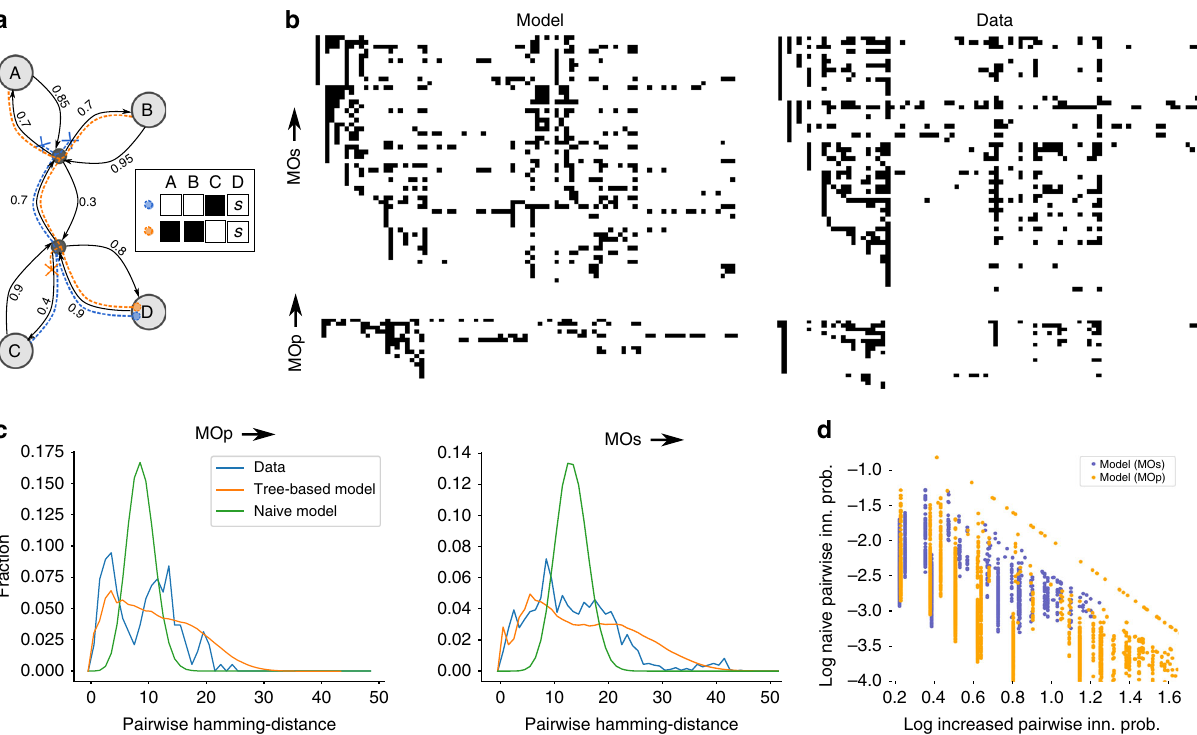
Fig. 6 A model to generate p-types. a Toy example of a p-type generating model with four regions (A – D). The regions are associated with the leaves of a directed tree (black), edges of the tree are associated with a probability to cross it. Two exemplary axons (orange, blue) spread from region D either crossing an edge (dashed lines) or not (dashed X-marks). Inset: resulting p-types; black regions are innervated; s indicates the source region. b Examples of innervation of brain regions predicted by the full model for L5IT (left column) and of reconstructed axons (right column). Sampled axons along the y -axis, brain regions along the x -axis. A black pixel indicates that an axon is innervating a region. Top row: axons originating from L5 of MOs; bottom row: from MOp. c Pairwise distances (hamming distance) between the pro fi les of brain region innervation. Blue: the data from reconstructed axons (see a ); orange: from 10,000 pro fi les sampled from the tree-based model; green: from 1000 pro fi les sampled from a naive model taking only the fi rst-order innervation probabilities into account. Left: for axons originating from MOp; right: from MOs. d Increase in innervation probability against the basic